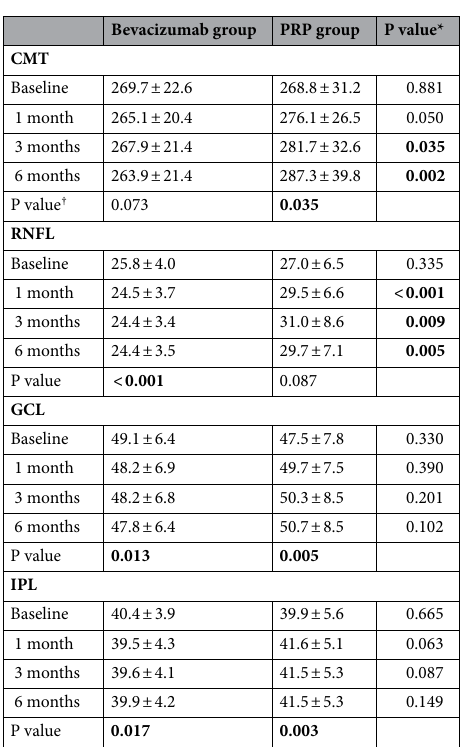
Table 2. Thickness of central macula and parafoveal inner retinal layer in each group. Values in boldface (P < 0.05) are statistically significant. All values are expressed as the mean ± SD (μm). CMT central